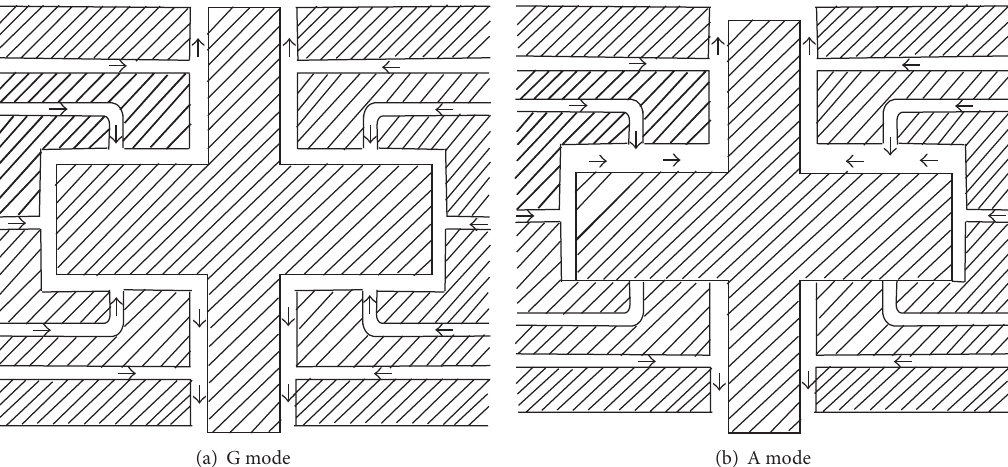
Figure 2: The dual mode spindle. (a) The G mode. The arrows indicate the flow direction of the air support. In the G mode, the spindle is supported both radially and axially like a conventional air bearing spindle. The spindle is under speed control circuitry to achieve high speed spinning with minimal jitter. (b) The A mode. In the A mode, the spindle is under the positioning control circuitry. It functions as a slow turning rotary table and can be clamped down for imaging when in position. To clamp down the spindle, the bottom axial air support is removed. As the result, the spindle body is pressed against the housing. The working pressure for the air spindle is 5 bars. Note the spindle shown in (b) is already in the clamped position.